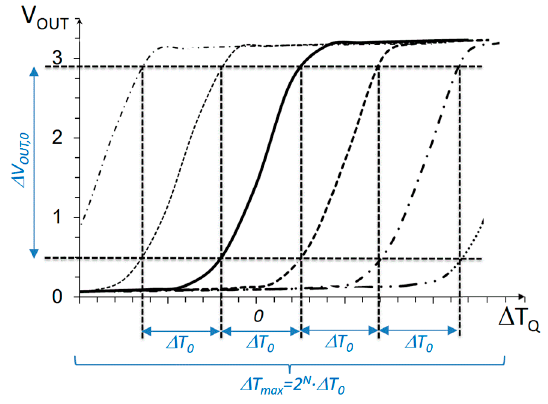
Figure 5. Characteristic curve of a differential temperature sensor with an extended dynamic range.